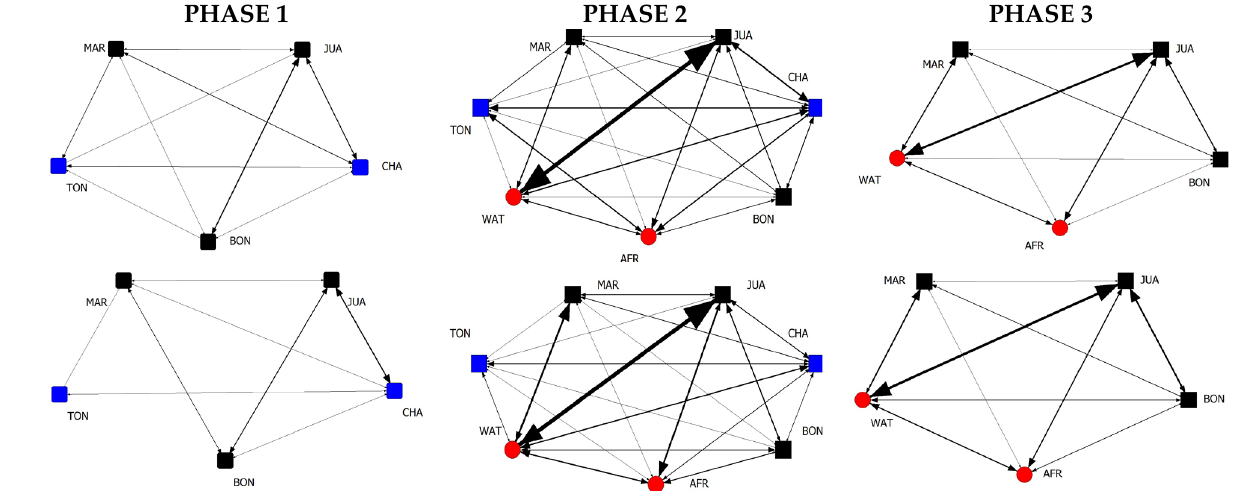
Figure 1. Social grooming networks of all 6 observation time periods based on the group composition (phase 1 vs. phase 2 vs. phase 3) and seasonality (cold vs. warm).